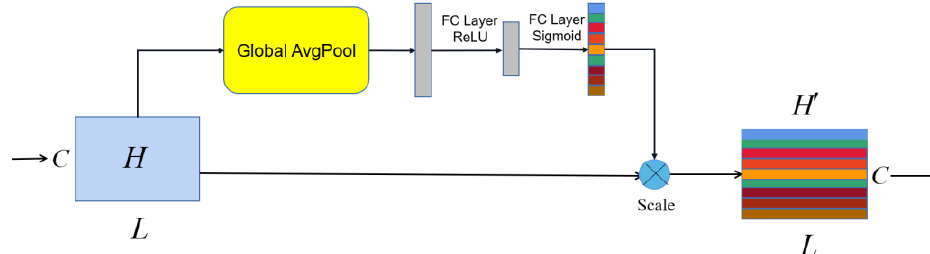
Figure 6. The structure of the channel attention.